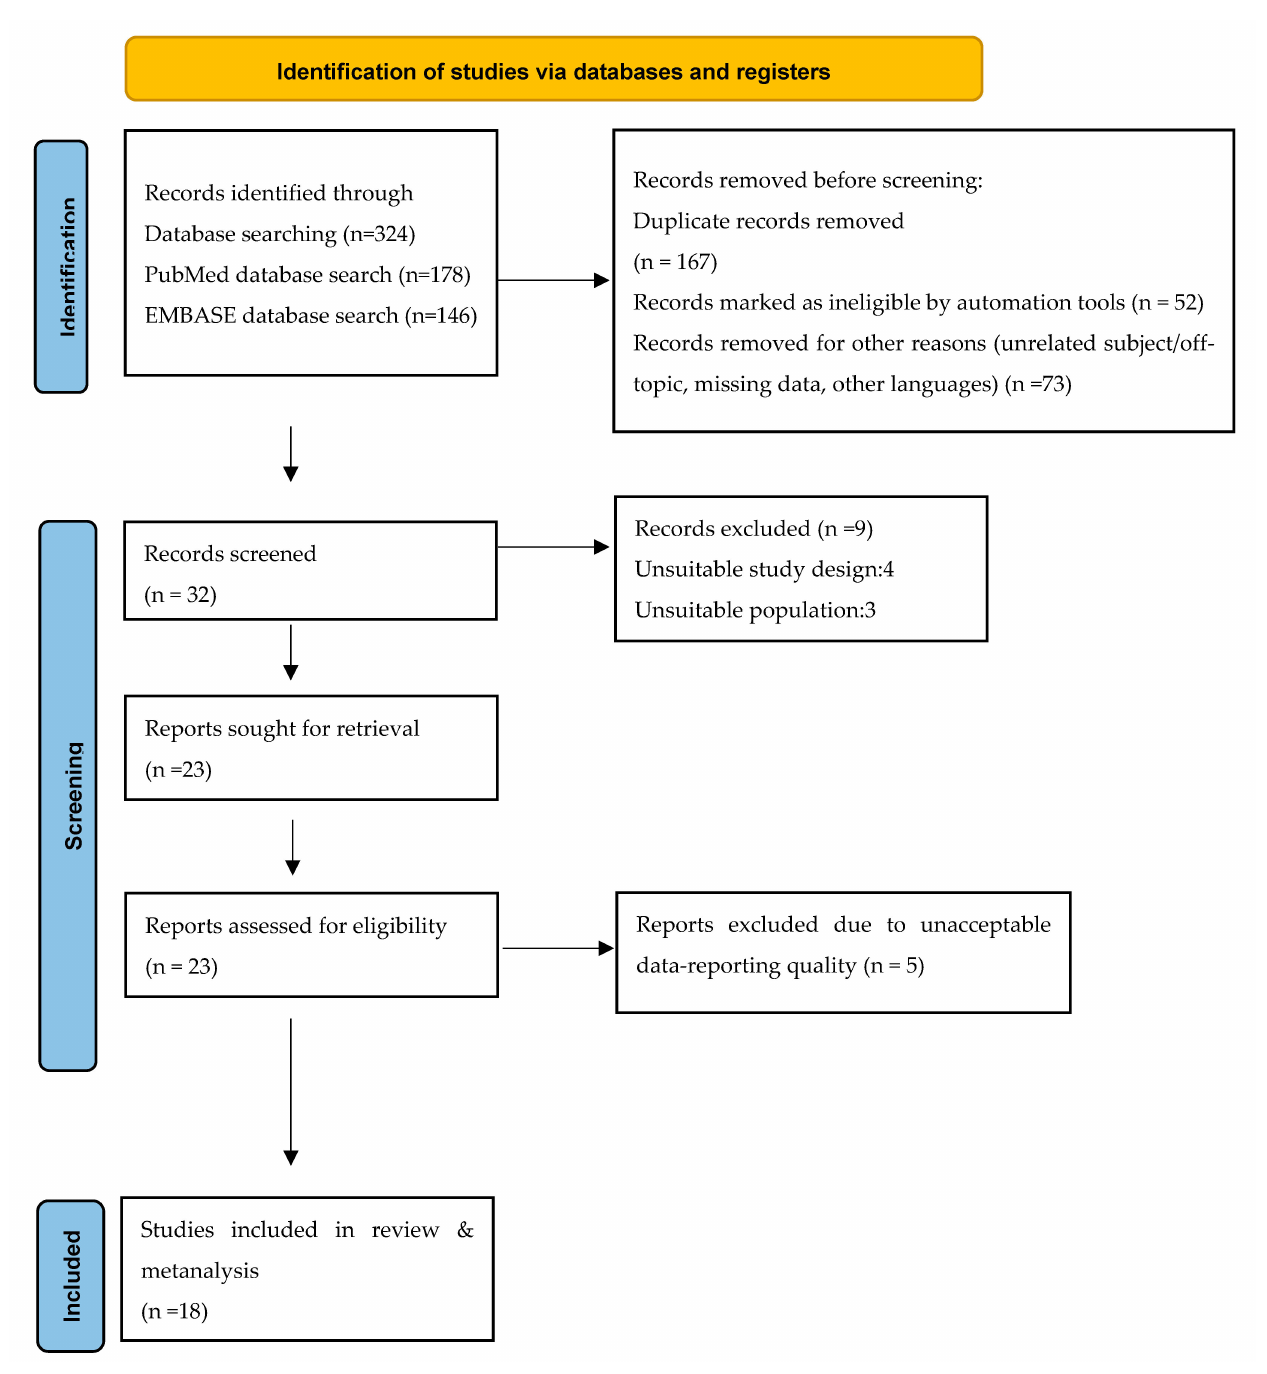
Figure 1. PRISMA flow diagram. Visualization of the process involving identification of records from databases, screening of records, assessing reports for eligibility, inclusion of eligible studies, and exclusion of non-eligible reports. The number of records or reports in each step of the process is shown in